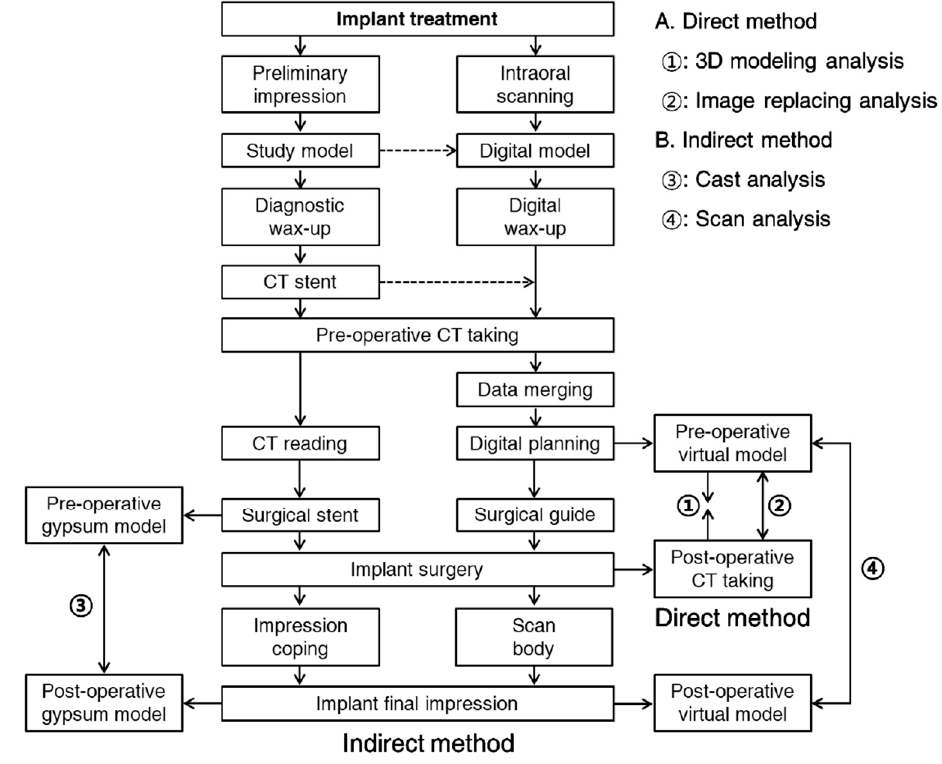
Figure 8. The process flow of the implant treatment and the principles of direct and indirect methods.